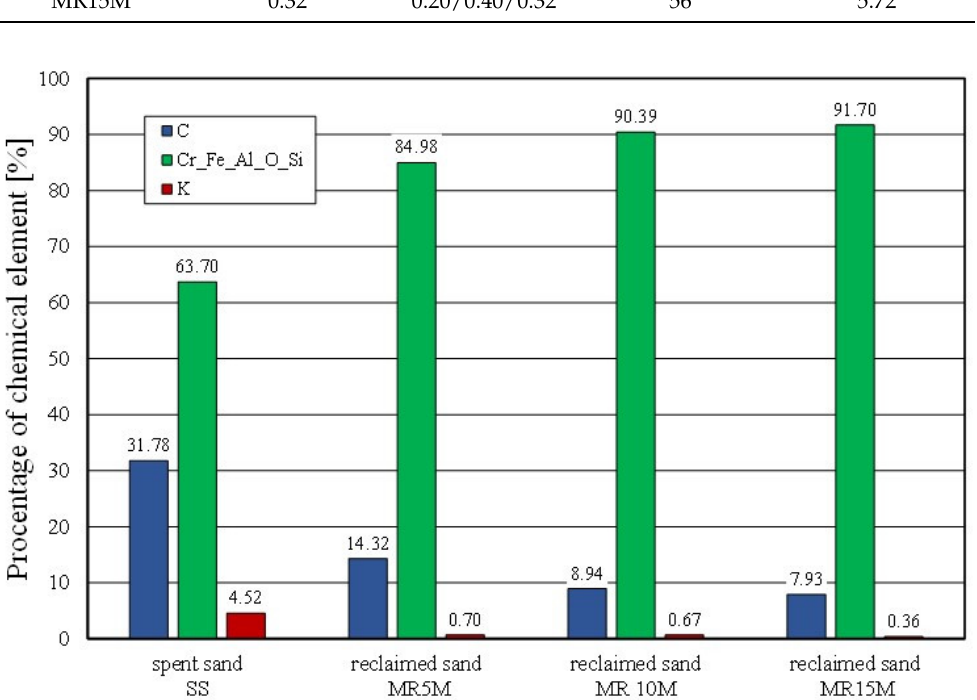
Figure 12. Comparison of chemical composition spent sand and reclaimed sand for different mechanical reclamation times.